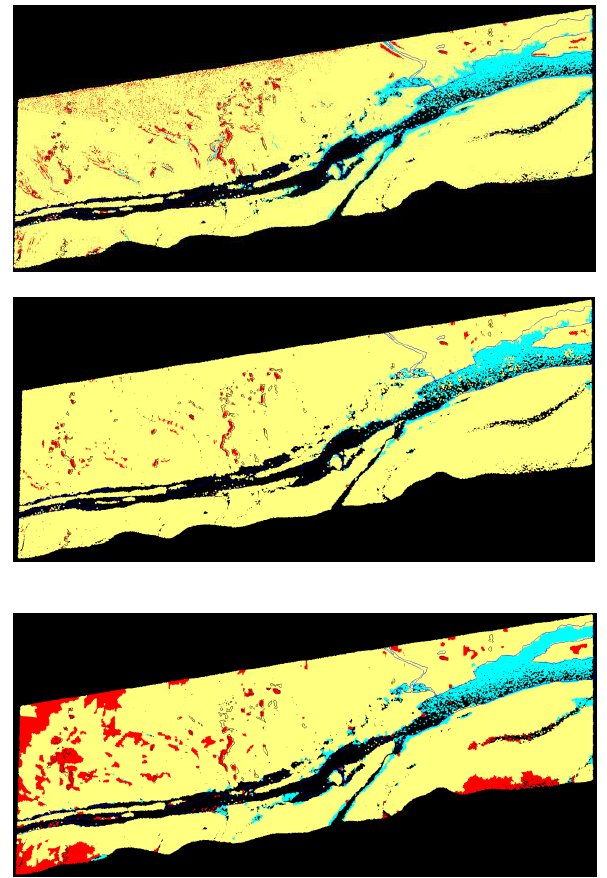
Figure 5: Classified point clouds obtained by Maximum Likelihood Classification (a) and the classification with our CRF approach for varying neighbourhood of N=2 (b) and N=4